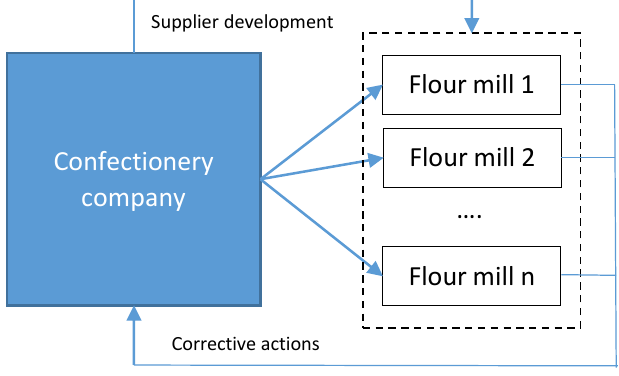
Figure 2. Scheme of supplier evaluation for